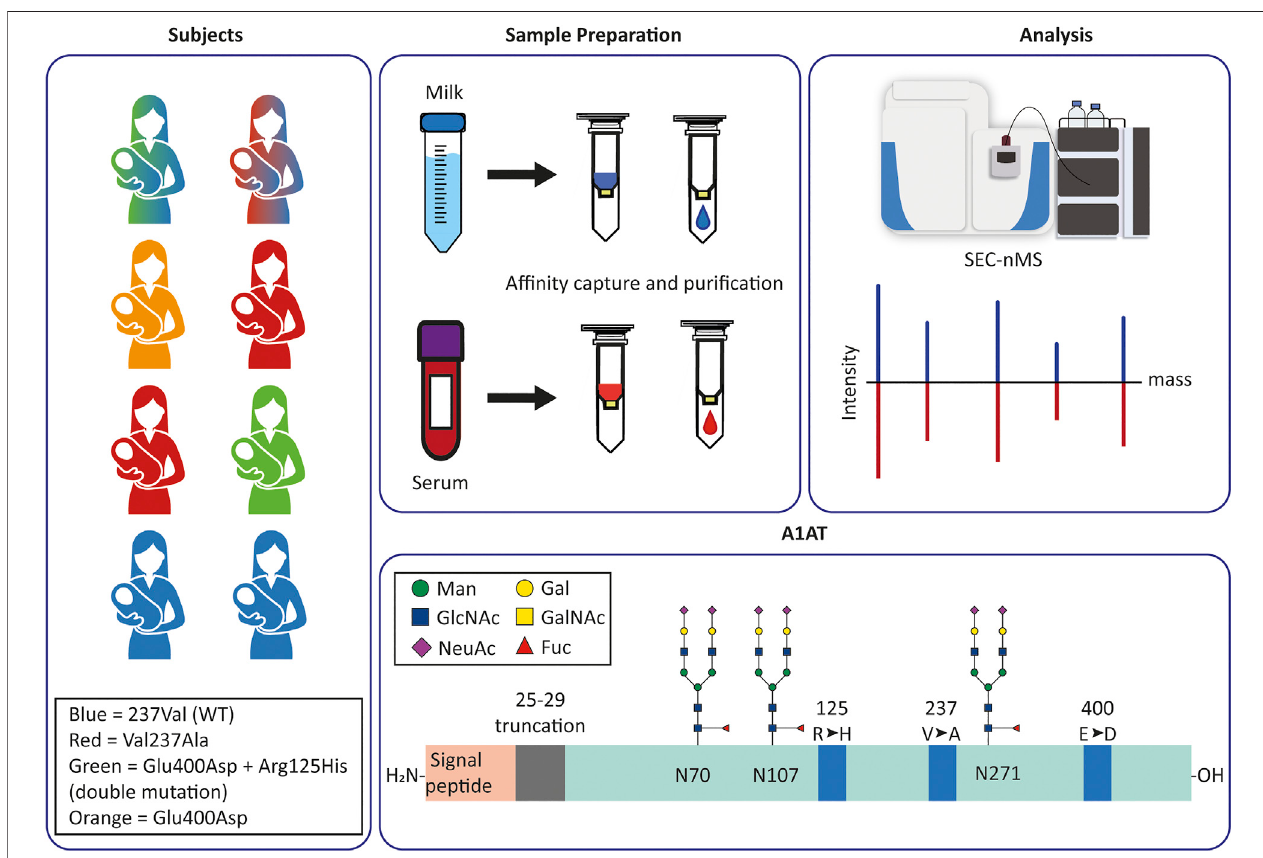
FIGURE 1 | Experimental design and set-up to monitor and compare personalized proteoform pro fi les of A1AT from serum and milk. (A) Milk and serum were collectedfromeightdonors.Thecolorsofeachdonorcorrespondtothedonor ’ sA1ATgenotype:blueisM1V(237Val),redisM1A(Val237Ala),greenisM2(Arg125His+ Glu400Asp), orange is M3 (Glu400Asp); double-colored fi gures represent donors heterozygous for A1AT. Thus, green and blue is heterozygous M1VM2, and red and blueisheterozygousM1AM1V. (B , C) A1ATwascapturedfromserumormilkusingimmuno-af fi nitybeads,thecollectedA1ATwassubsequentlyfurtherpuri fi edby using a SEC column coupled to a high-resolution mass spectrometer. The acquired data was deconvoluted to zero-charge to provide an individual mass pro fi le where peaks represent different proteoforms. These pro fi les can then be compared within a single donor between serum and milk, or between donors in serum or milk. (D) Schematic overview of the A1AT protein, with in orange the (cleaved) signal peptide and in green the mature circulating protein. Indicated are the three N-glycosylation sites, andthemutationhotspots(blue)de fi ningthedifferentgenotypes. Indicatedingrey isthe5 aminoacidstretchthatisoccasionallymissinginaN-terminaltruncated form of A1AT. The glycan structures represent the most common glycoforms, an overview of other prevalent glycoforms can be found in Supplementary Figure S1 .